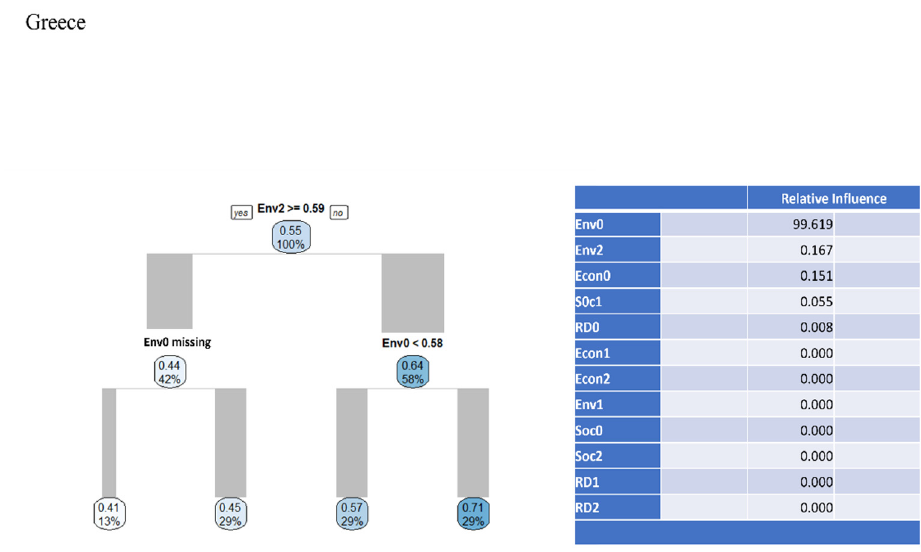
Figure 6. CART trees for Greece under the proposed, alternative metric two-stage DEA.